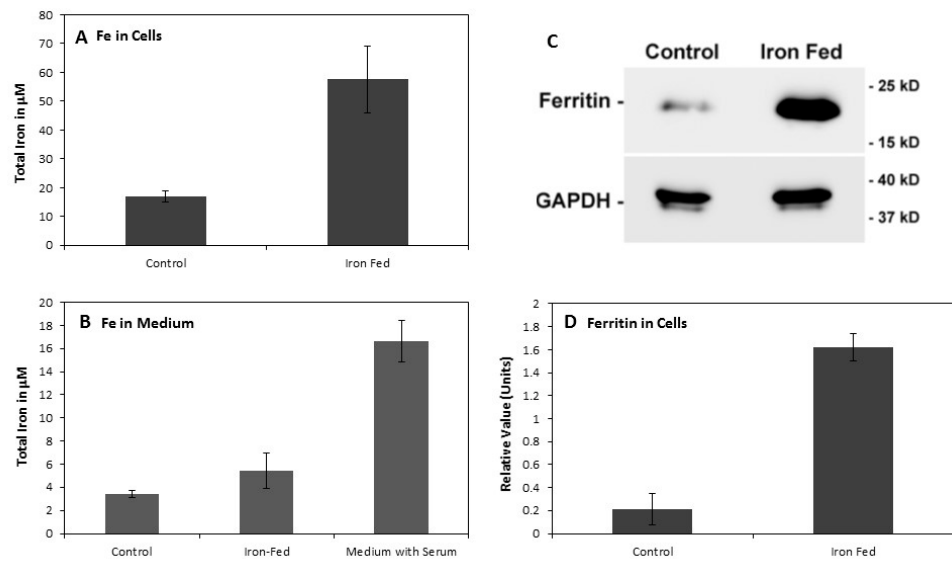
Figure 2. Changes in iron storage C8B4 microglia that had been grown in the presence of high ferric ammonium citrate were analysed for changes in iron content, iron release, and ferritin expression. ( A ) We used a commercial kit to analyse the iron content of microglia grown in 500 µ M iron for at least two weeks. Microglia were washed three times before analysis to remove excess iron from the medium. Extracts were then made from the microglia and the iron content determined for both control and iron-fed microglia. The analysis showed a high and significant ( p < 0.05) change in the iron within C8B4. ( B ) The level of iron released into the culture medium was assessed similarly. Conditioned medium (B27 supplemented DMEM was produced from control and iron-fed C8B4